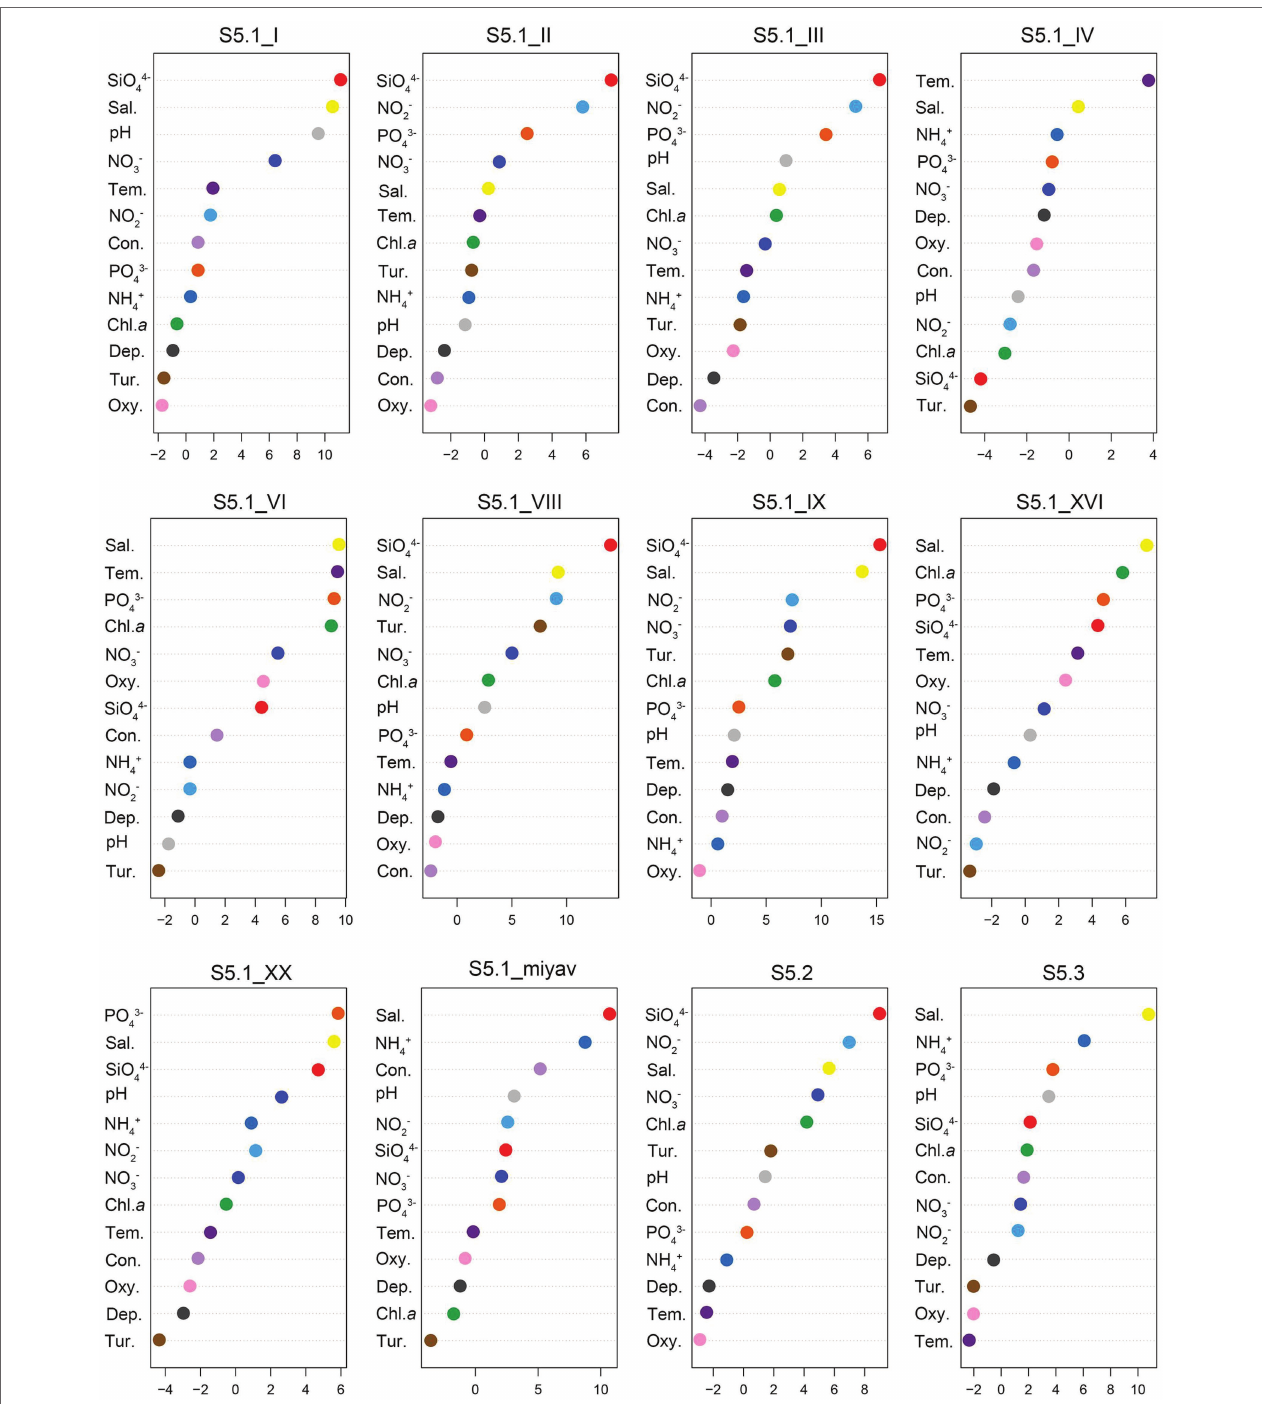
FIGURE 6 | Random forest (RF) analysis between each Synechococcus clade and environmental variables. Sal, salinity; Tem, temperature; Con, conductivity; Dep, depth; Tur, turbidity; and Oxy, oxygen saturation. Abscissas are %ImcMSE evaluating the materiality of environmental variables to each Synechococcus clade in